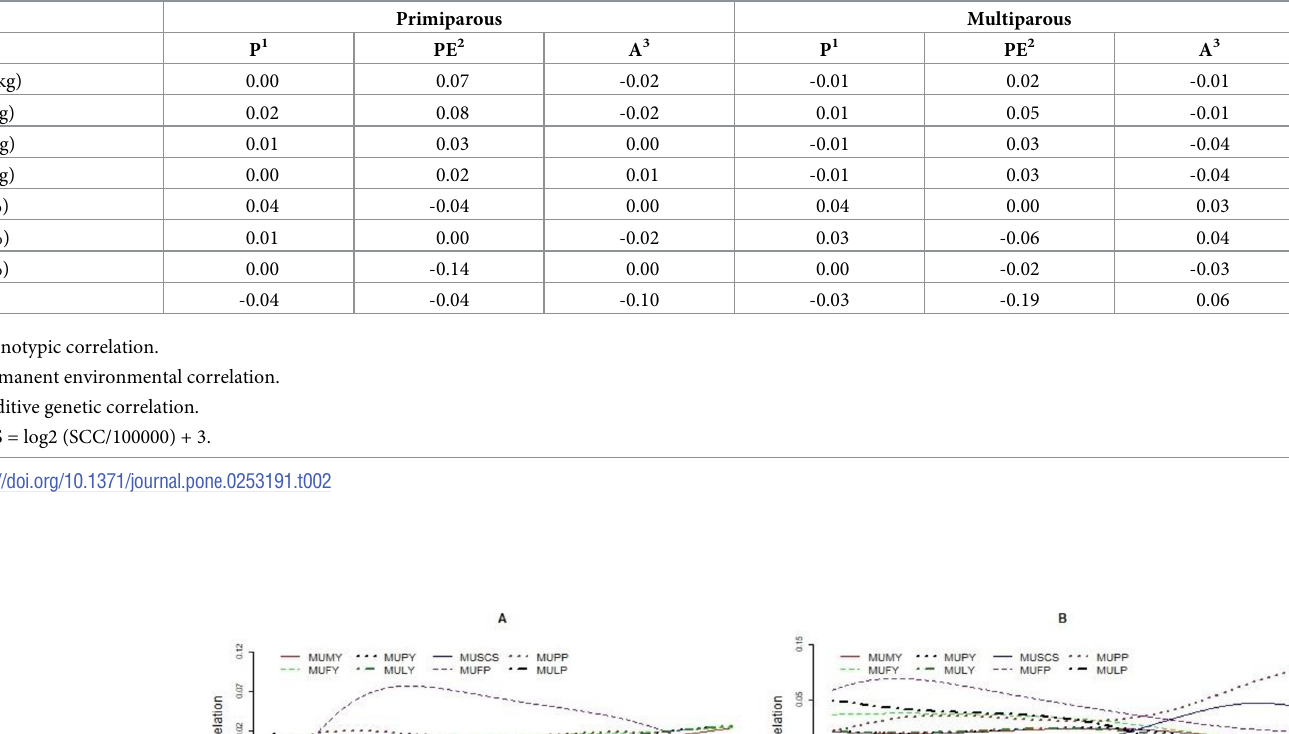
Table 2. Phenotypic, permanent environmental, and genetic correlations between MU and milk yield and compositions in primiparous and multiparous cows.